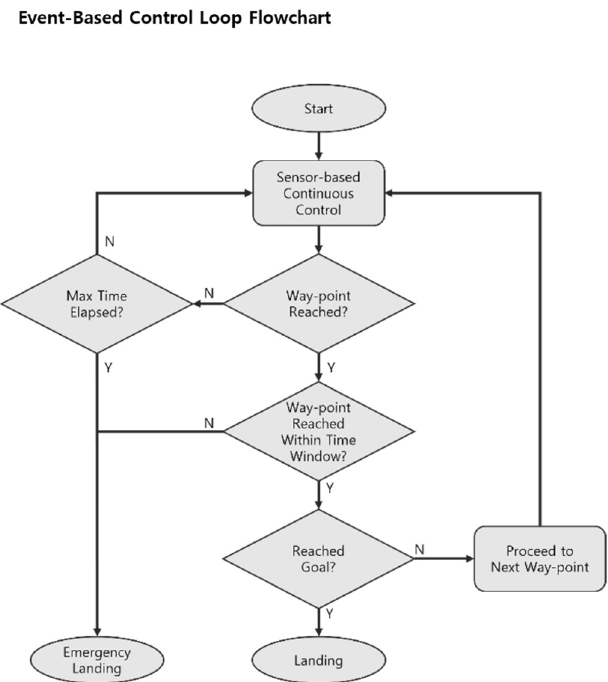
Figure 4. Control flowchart illustrating the control loop implemented in the event-based controller. The event-based controller will not accept both early and late arrivals at each designated waypoint. If the drone does not arrive inside the time-window, the event-based controller will consider the situation an emergency.